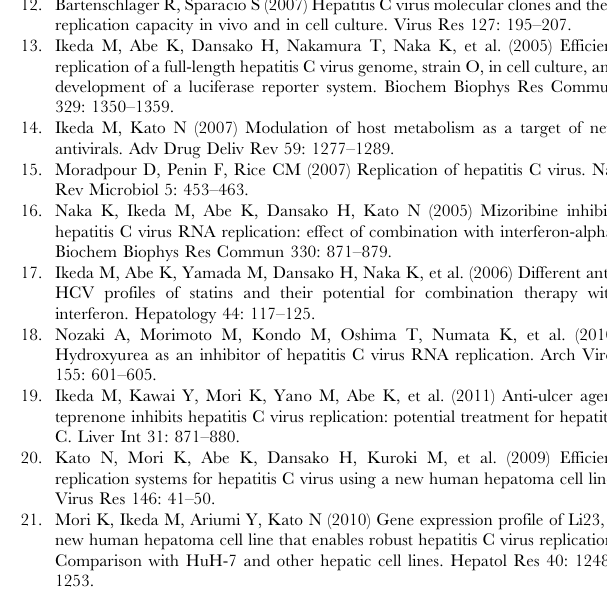
genotype 1b) replication in the 1B-4RL assay. The RL assay and WST-1 assay were performed as described in (A). (D) Effects of N- 89 and N-251 on genome-length HCV-RNA (HCV KAH5 strain of genotype 1b) replication in the KAH5RL assay. The RL assay and WST-1 assay were performed as described in (A). (E) Effects of N-89 and N-251 on HCV subgenomic replicon RNA (HCV O strain of genotype) replication in the sOR assay. The RL assay and WST-1 assay were performed as described in (A). (F) Effects of N- 89 and N-251 on HCV subgenomic replicon RNA (HCV O strain of genotype 1b) replication in the sORL8 assay. The RL assay and WST-1 assay were performed as described in (A). (G) Effects of N- 89 and N-251 on HCV subgenomic replicon RNA (HCV O strain of genotype 1b) replication in the sORL11 assay. The RL assay and WST-1 assay were performed as described in (A). (TIF) Figure S2 No inhibition of RL activity by N-89 or N-251. (A) N-89 and N-251 did not inhibit the RL activity in the OR6 cell lysate. N-89 or N-251 was added to the OR6 cell lysate, and then an RL assay was performed. (B) N-89 and N-251 did not inhibit the RL activity in the ORL8 cell lysate. N-89 or N-251 was added to the ORL8 cell lysate, and then an RL assay was performed. (TIF) Figure S3 N-251 did not inhibit the HCV-JFH-1 replica- tion. RSc and D7 cells were inoculated with supernatant from RSc cells replicating JR/C5B/BX-2 [2]. The RL assay was performed as described in Fig. S1A. (TIF) Figure S4 Anti-HCV effects of N-89 or N-251 in combi- nation with IFN- a and/or RBV on HCV-RNA replication in OR6 cells. Open symbols in the broken lines show the values expected as an additive anti-HCV effect and closed symbols in the solid lines show the values obtained by the OR6 assay. (A) Effect of N-89 or N-251 in combination with IFN- a on OR6 assay. OR6 cells were treated with N-89 (upper panel) or N-251 (lower panel) in combination with IFN- a for 72 hrs and subjected to RL assay. (B) Effect of N-89 or N-251 in combination with RBV on OR6 assay. OR6 cells were treated with N-89 (upper panel) or N-251